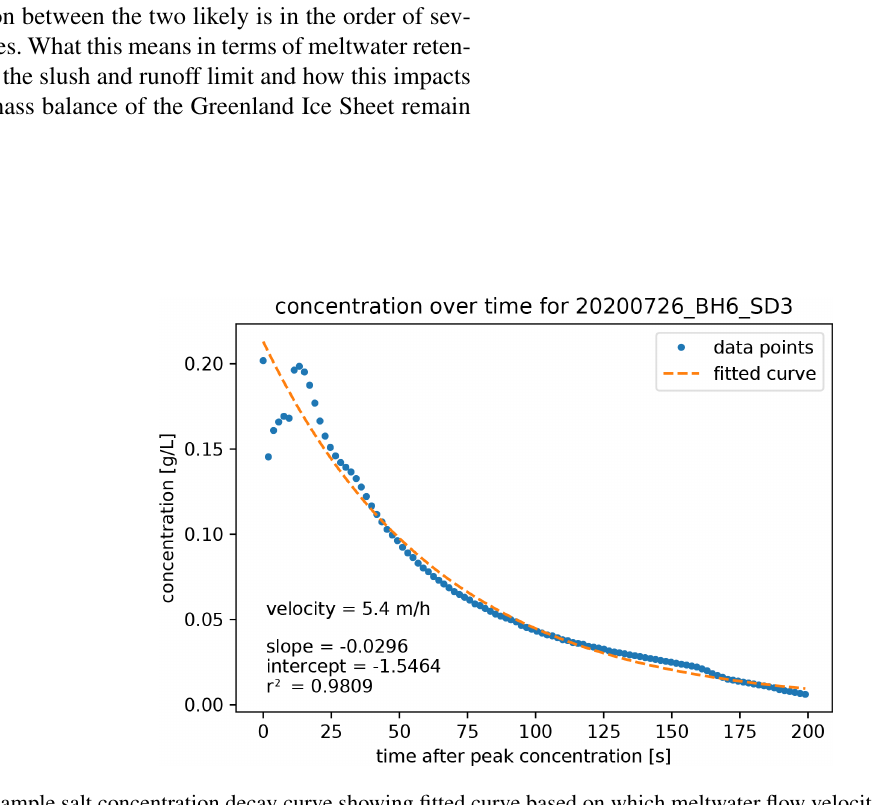
Figure A1. Example salt concentration decay curve showing fitted curve based on which meltwater flow velocity was calculated.